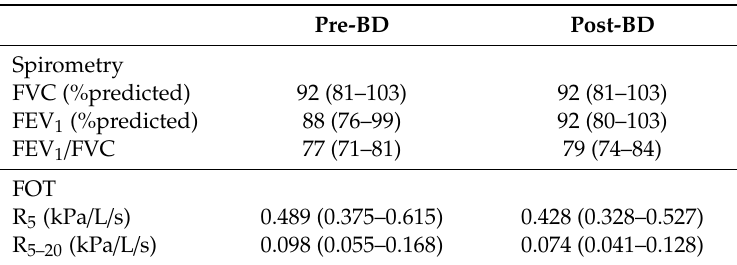
Table 2. Lung function at initial visit ( n =